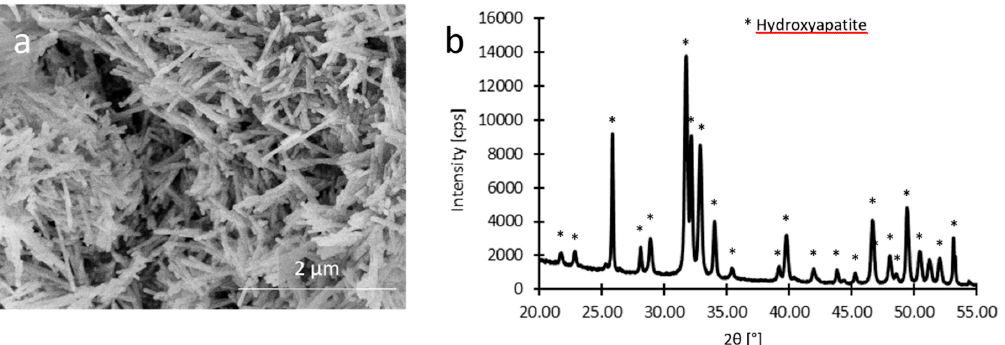
Figure 2. ( a ) SEM image of hydroxyapatite nanoparticles after the hydrothermal treatment, ( b ) XRD spectrum of synthetized hydroxyapatite particles.